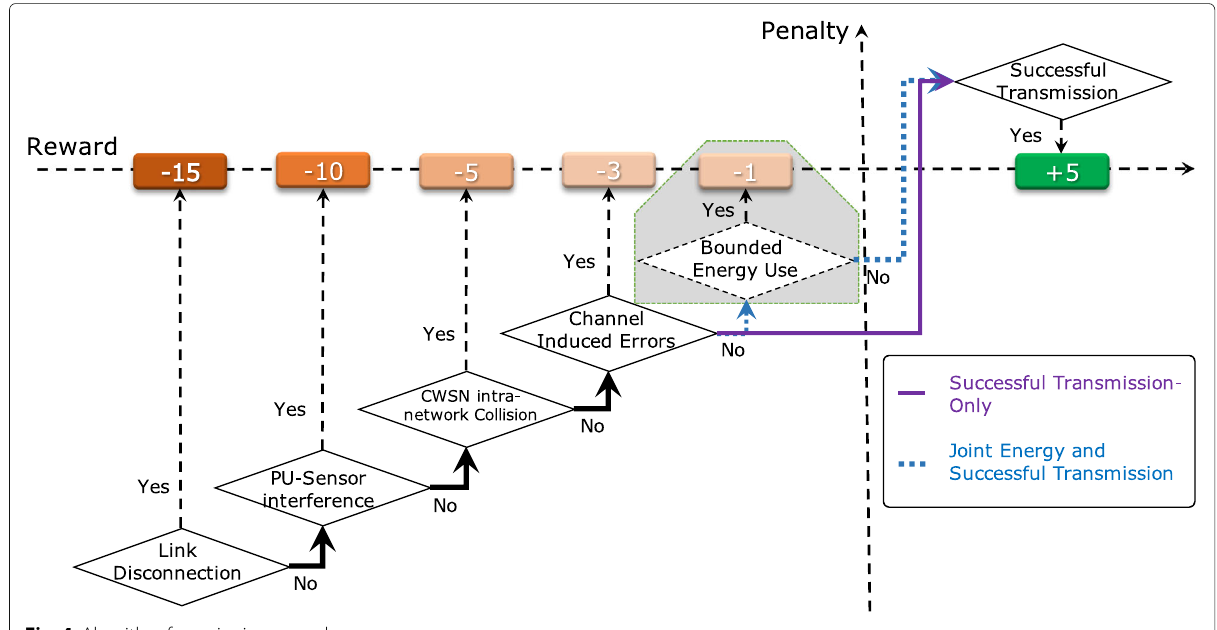
Fig. 4 Algorithm for assigning